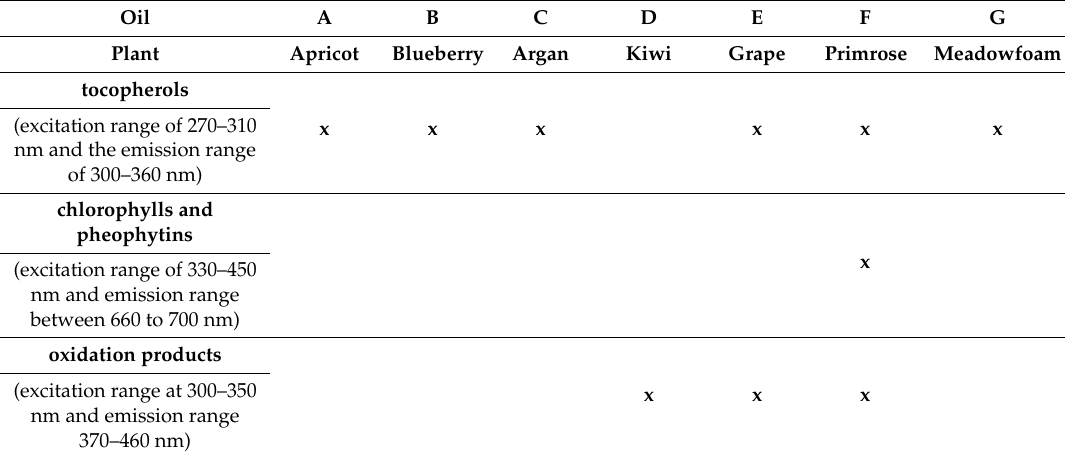
Table 2. Spectral profile of studied oils.